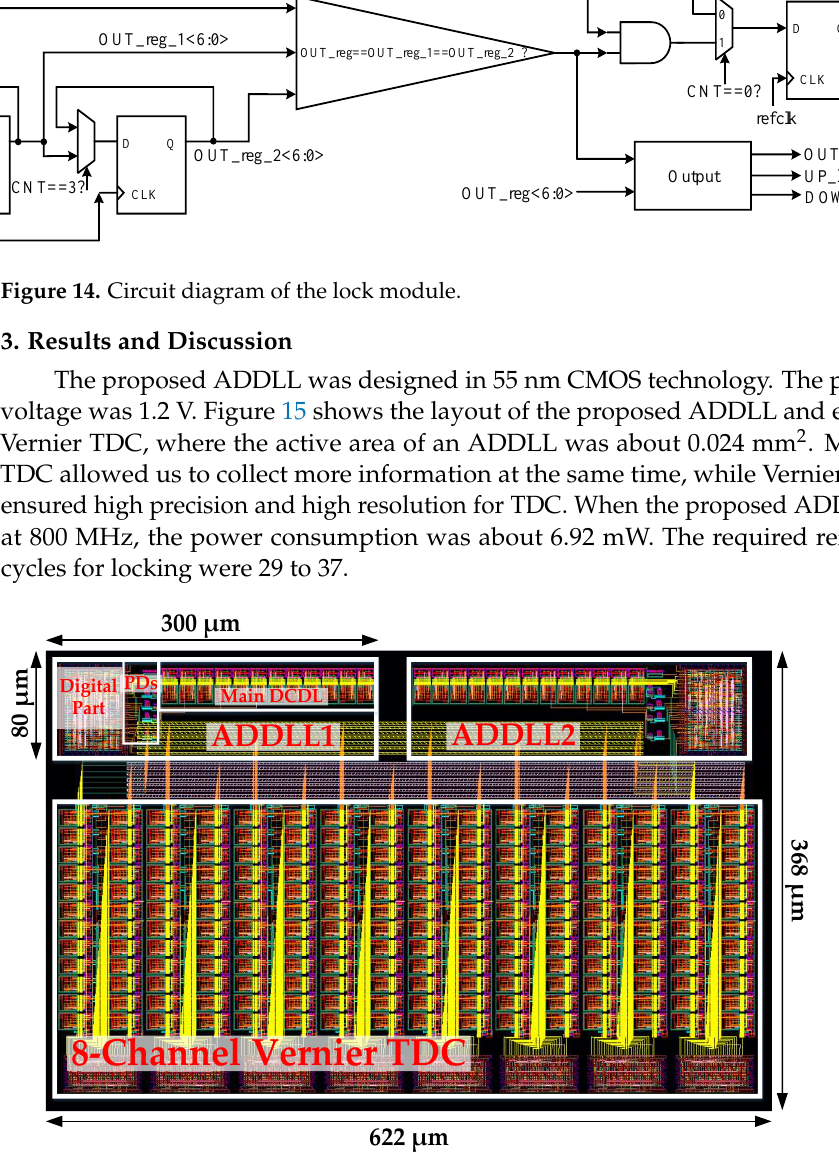
Figure 15. Layout of the proposed ADDLL and Vernier TDC of 8 channels.